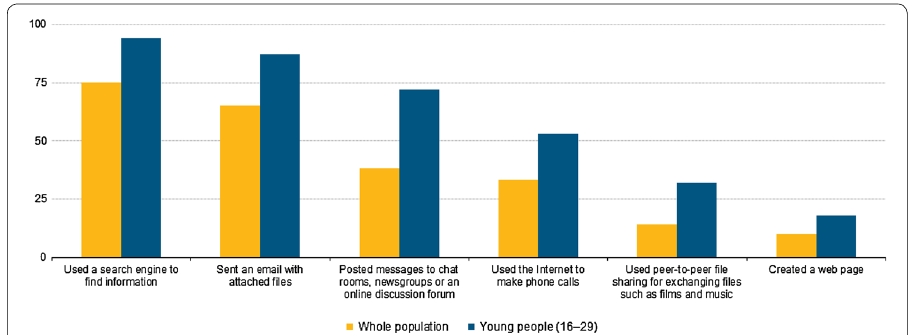
Fig. 4 Proportion of people who used selected internet skills, EU-28 (data from 2013; source: Eurostat